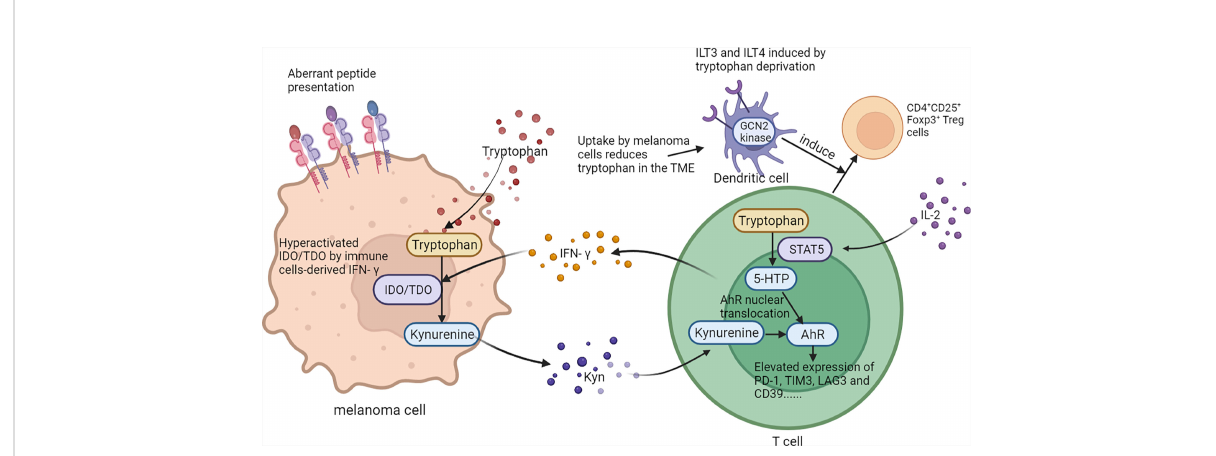
FIGURE 4 The role of tryptophan metabolism in melanoma immunology. On one hand, abnormally activated IDO1/TDO pathway of tryptophan in melanoma cells contributes to a diversi fi ed peptidome landscape and aberrant transframe peptides which could facilitate immune recognition. On the other, tryptophan in TME can affect the function and differentiation of T cells.